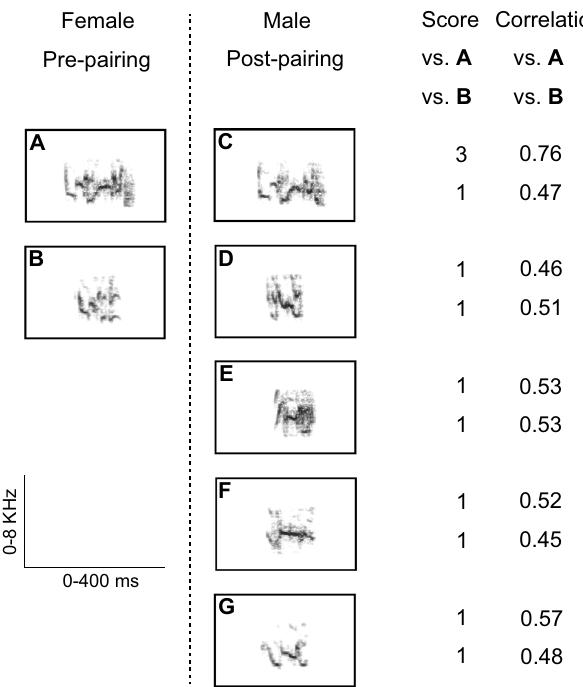
Figure 1. Sonograms of CCs. The female pre-pairing (left column) had two types of CC ( A , B ), and the male at 5 weeks post-pairing (right column) had five types of CC ( C – G ). We randomly selected five exemplar sonograms of each CC type and used them for rating the CC Similarity Score (Score). In each of 10 pairwise comparisons, the CC Similarity Score was rated as 1 (no similarity), 2 (modest similarity), or 3 (good similarity). Only type C was rated as good similarity and had a cross-correlation value (Correlation) greater than 0.75. In cross-correlations between two CCs from different CC types, values greater than 0.75 are highly unlikely to occur by chance 38 . Type C was not present in the CC repertoire of male